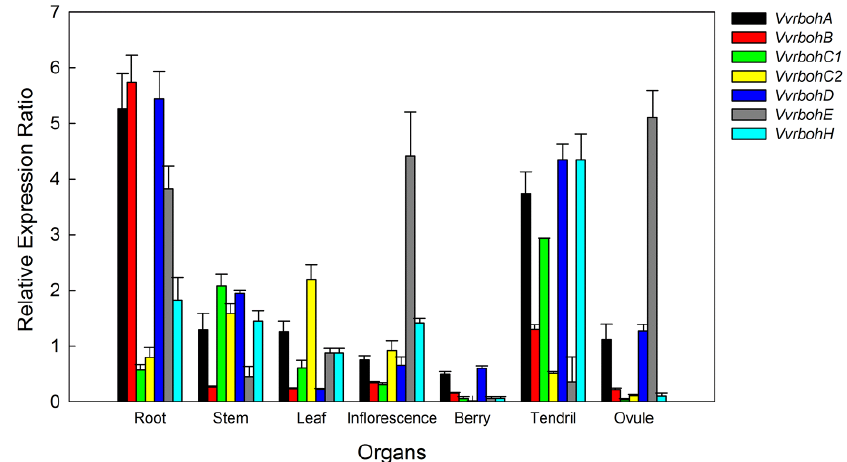
Figure 5. The expression profiles of seven Vvrboh genes in various tissues. qRT-PCR analysis was conducted to visualize Vvrboh gene expression. Amplification of actin1 was used as an internal control. Error bars represent standard error (SE; n =